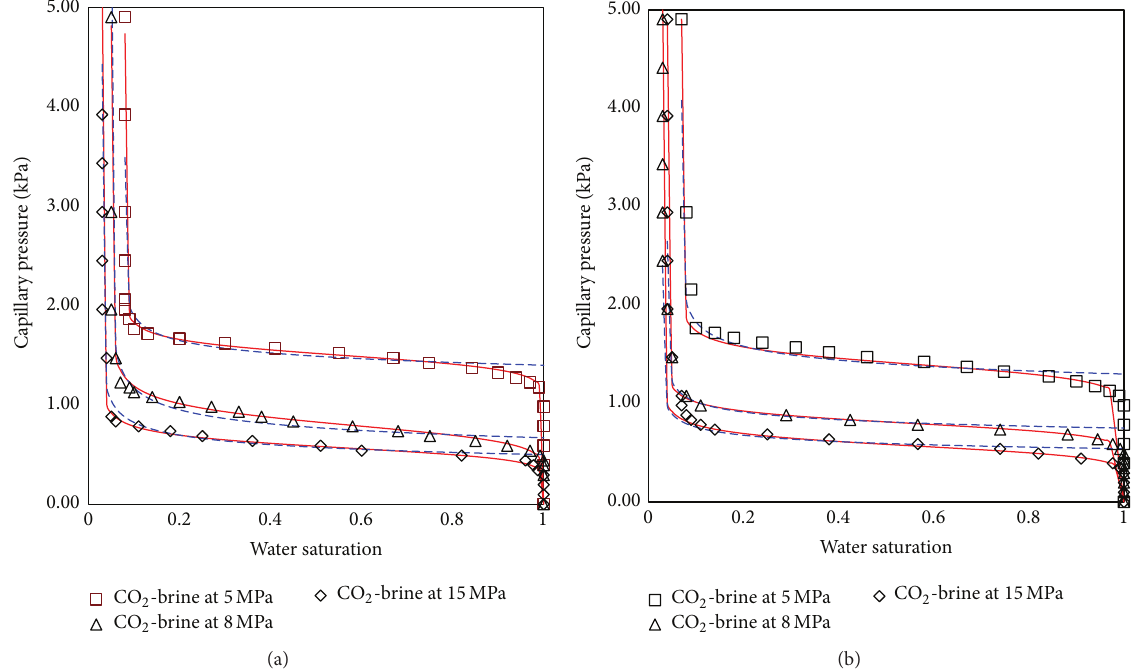
Figure 7: Capillary pressure-water saturation curves based on experiments and theoretical models. (a) Drainage and (b)